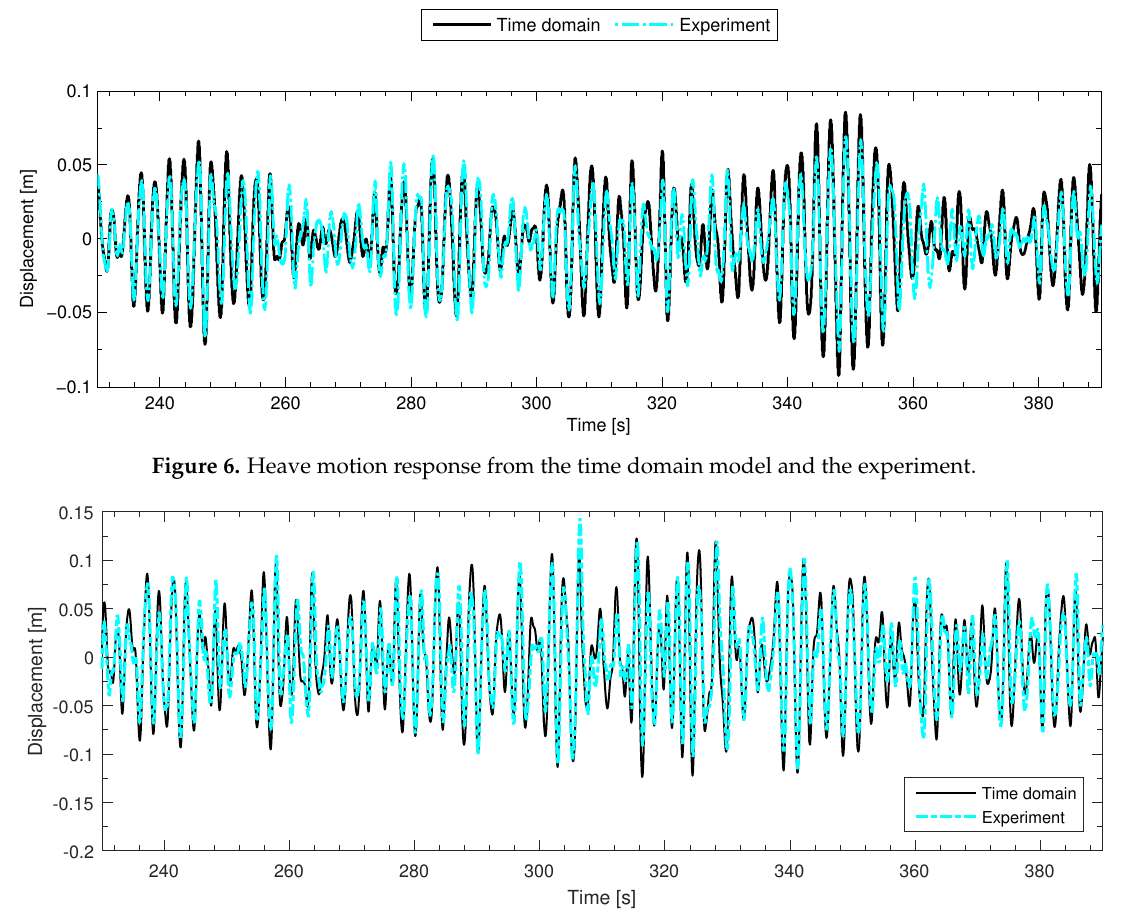
Figure 7. Surge motion response from the time domain model and the experiment.